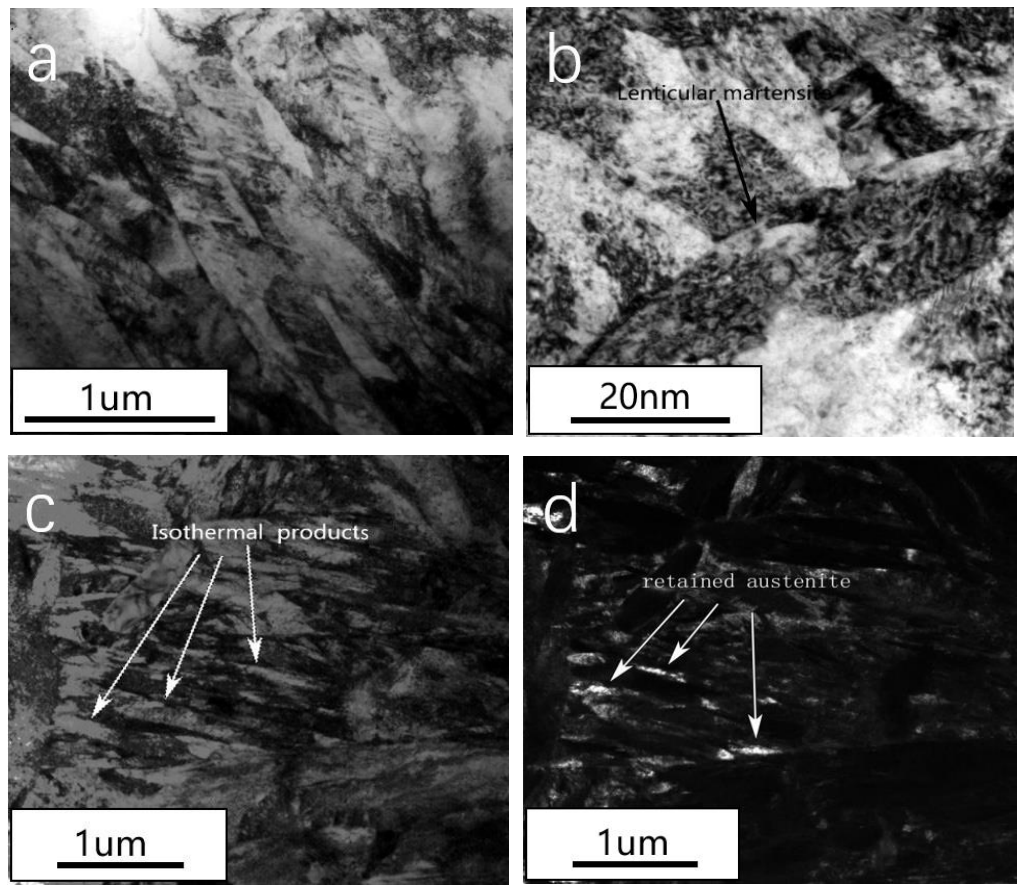
Figure 9. TEM image after Q & P: ( a ) lath martensite ( b ) lenticular martensite ( c ) isothermal production, and ( d ) retained austenite (dark film).